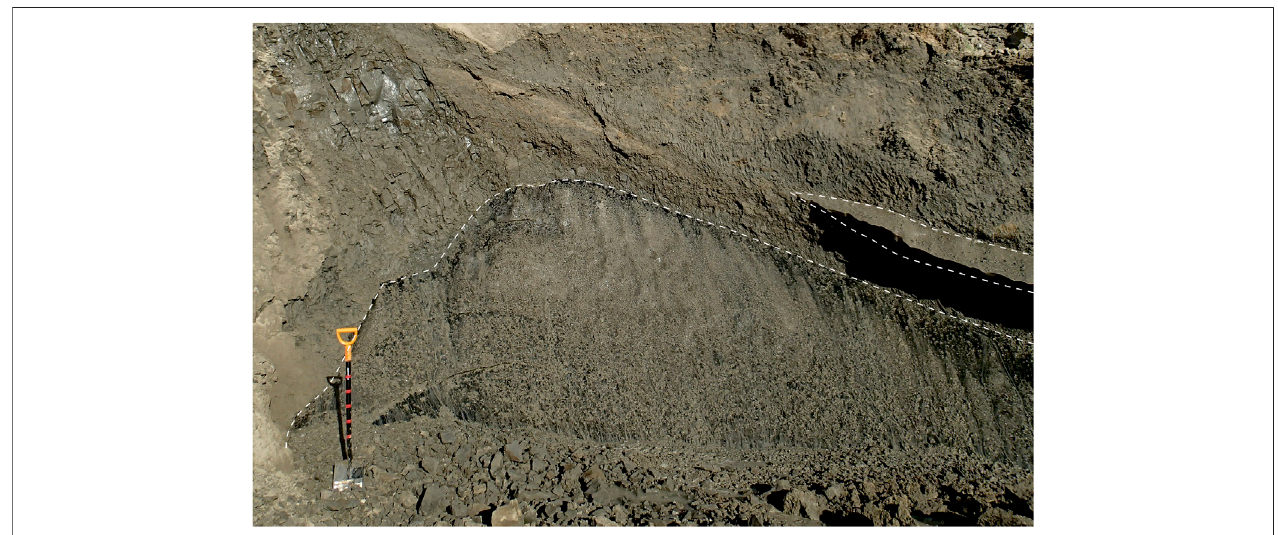
FIGURE 3 | Coastal exposure of massive ice beds near Cape Yasalya. The dashed line shows the boundaries of the ice body.